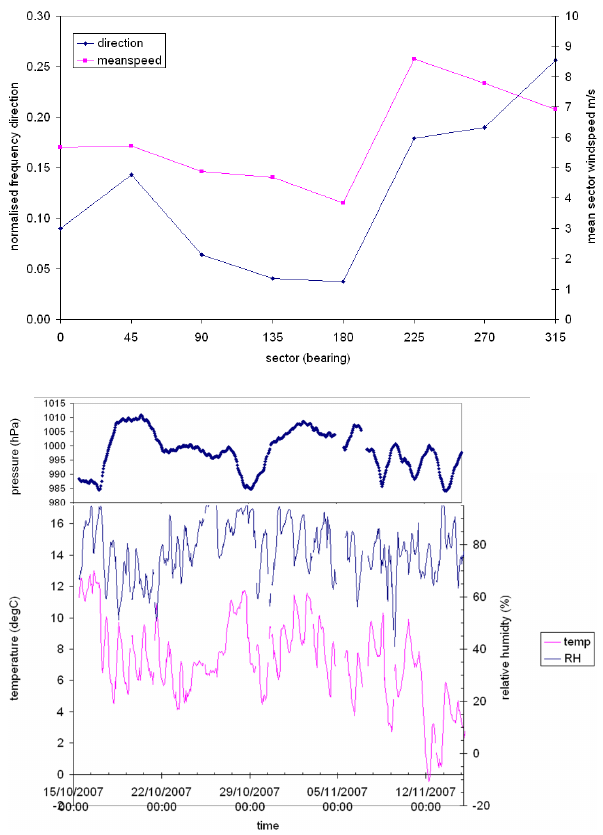
Fig. 2. Meteorological data measured using Vaisala WXT510 weather station at BT Tower during REPARTEE II. (a) Mean wind- speed and direction frequency data per 45 ◦ sector. (b) Time series of temperature, relative humidity and pressure data for BT Tower.